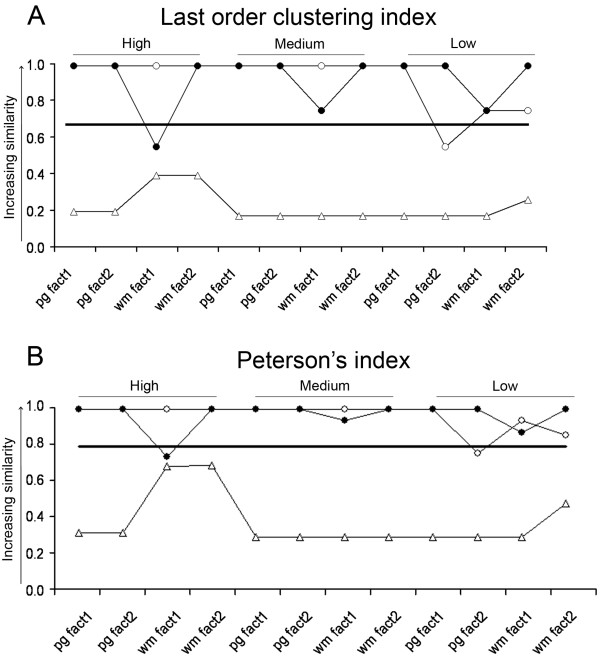
Segregation of cervical and lumbar limb moving motoneurons based on somatopetal propagation of voltage transients. Cluster analysis was used with the Pair group and Ward’s methods (see horizontal labels starting with ‘pg’ and ‘wm’) with differently weighted (‘fact1’ and ‘fact2’) descriptors. These descriptors were the standardized and area weighted percentiles of somatic to dendritic ratios of peak potentials (open triangles), half-widths (closed circles) and rise times (open circles) of PSPs to quantify the changes in shape of voltage transients generated by conductance changes according to an α-function (gmax = 2 nS, tmax = 1.5 ms). Last order clustering index (A) and Peterson’s homogeneity index (B) were used to measure homogeneities within last order clusters, which reflect segregation of cervical and lumbar MNs between these clusters. Homogeneity indexes with values closer to one indicate higher similarity (poorer segregation) of cervical and lumbar MNs. Continuous horizontal lines mark levels of homogeneities below which separation of MNs is significant. ‘High’, ‘Medium’, and ‘Low’ levels of synaptic background activities on dendrites were modeled by 5000, 20000 and 50000 Ωcm2 specific dendritic membrane resistivities respectively.